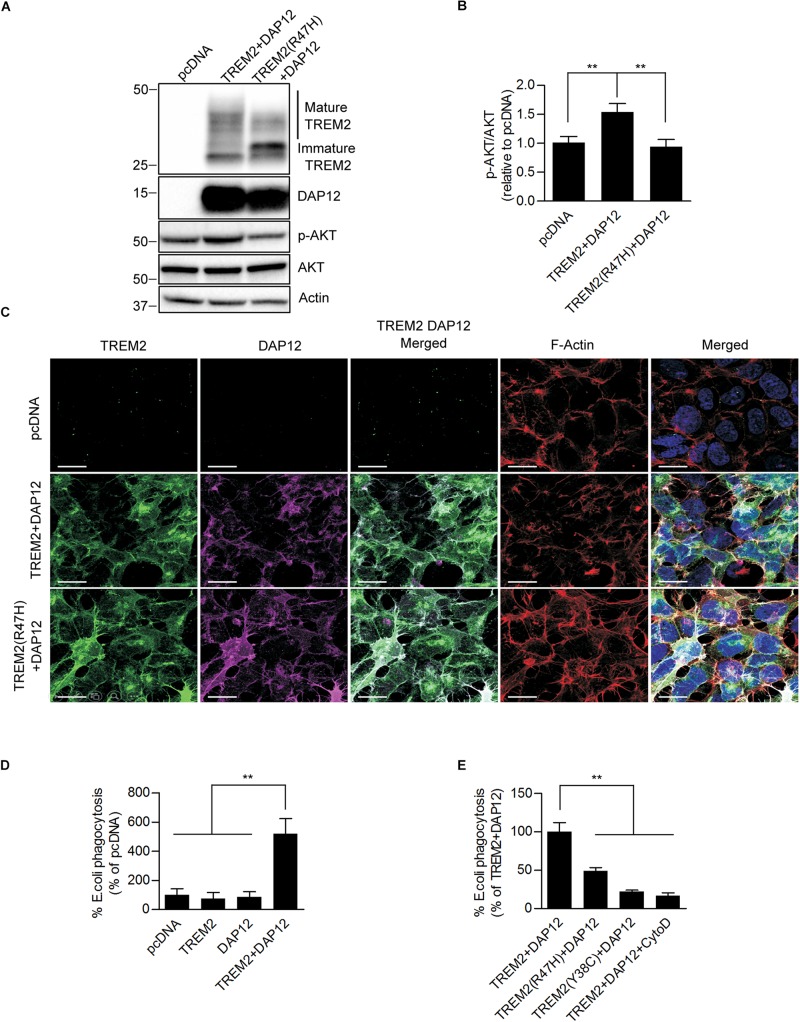
Ectopic expression of TREM2 and DAP12 induces AKT activation and phagocytosis in HEK293 cells. (A) Western-blot analysis of lysates from HEK293 cells transfected with pcDNA (control empty vector), TREM2 + DAP12 and TREM2 (R47H) + DAP12 constructs. A representative western-blot showing the impact of TREM2 + DAP12 and TREM2(R47H) + DAP12 expression on p-AKT(Ser473) compared to HEK293 cells transfected with the empty pcDNA vector (control) is shown. (B) Histogram representing the quantification by western-blots of p-AKT(Ser473) normalized to total AKT in HEK293 cells transfected with pcDNA (empty vector), TREM2 + DAP12 and TREM2(R47H) + DAP12 constructs. Data represent the average ± SD p-AKT/Total AKT levels standardized to values obtained in HEK293 cells transfected with the pcDNA empty vector; (n = 4) for each experimental condition; statistical significance (∗∗p < 0.01) was evaluated by ANOVA followed by post hoc analysis using Bonferroni corrections. (C) Representative laser confocal images of HEK293 cells transfected with pcDNA (empty vector), TREM2 + DAP12 and TREM2(R47H) + DAP12 following immunostaining with N-terminal TREM2 (green), DAP12 (purple) antibodies. Cells were counterstained with DAPI (blue) and fluorescent phalloidin (red) to stain F-actin. TREM2 and DAP12 expression was detected in HEK293 cells transfected with TREM2 + DAP12 and TREM2(R47H) + DAP12 constructs while no expression of TREM2 and DAP12 was observed in HEK293 cells transfected with the empty vector (pcDNA). Colocalization between TREM2 and DAP12 was observed both in cells co-expressing wild-type TREM2 and DAP12 and in cell co-expressing the TREM2 R47H mutation and DAP12. The white scale bar represents 20 μm. (D) Phagocytosis of pHrodo E. coli bioparticles conjugate in pcDNA, TREM2, DAP12, or TREM2 + DAP12 transfected HEK293 cells. Data are represented as mean ± SD from at least two independent cell culture experiments and expressed relative to data obtained in HEK293 transfected with the pcDNA empty vector; (n = 6) for each experimental condition; statistical significance (∗∗p < 0.01) was evaluated by ANOVA followed by post hoc analysis using Bonferroni corrections. Data show that the co-expression of DAP12 with TREM2 significantly stimulates the phagocytosis of pHrodo E. coli bioparticles whereas DAP12 or TREM2 expression alone are not sufficient to promote phagocytic activity compared to HEK293 transfected with the empty vector pcDNA (control). (E) Phagocytosis of pHrodo E. coli bioparticles conjugate in TREM2 + DAP12, TREM2(R47H) + DAP12, and TREM2(Y38C) + DAP12 transfected HEK293 cells. TREM2 + DAP12 transfected HEK293 cells were also treated with cytochalasin D (10 μM), an inhibitor of actin polymerization which blocks phagocytosis (positive control). Data are represented as means ± SD from at least two independent cell culture experiments and expressed as a percentage of the amount of phagocytosis quantified in TREM2 + DAP12 transfected HEK293 cells; (n = 6) for each experimental condition; statistical significance (∗∗p < 0.01) was evaluated by ANOVA followed by post hoc analysis using Bonferroni corrections. Data show that that cytochalasin D antagonizes TREM2 + DAP12 dependent phagocytic activity while TREM2(R47H) reduced phagocytosis by 50% and TREM2(Y38C) by 80% compared to wild-type TREM2.